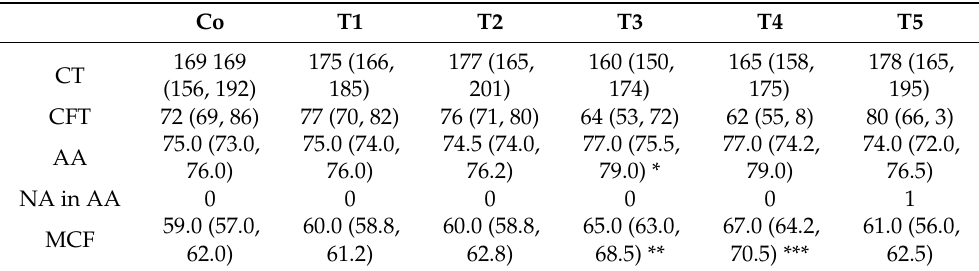
Table 5. Dynamics of CT, CFT, AA, and MCF values in HEPTEM in high-risk patients during pregnancy, after the postpartum period and in the control group. Data are presented in the form of medians and interquartile ranges.